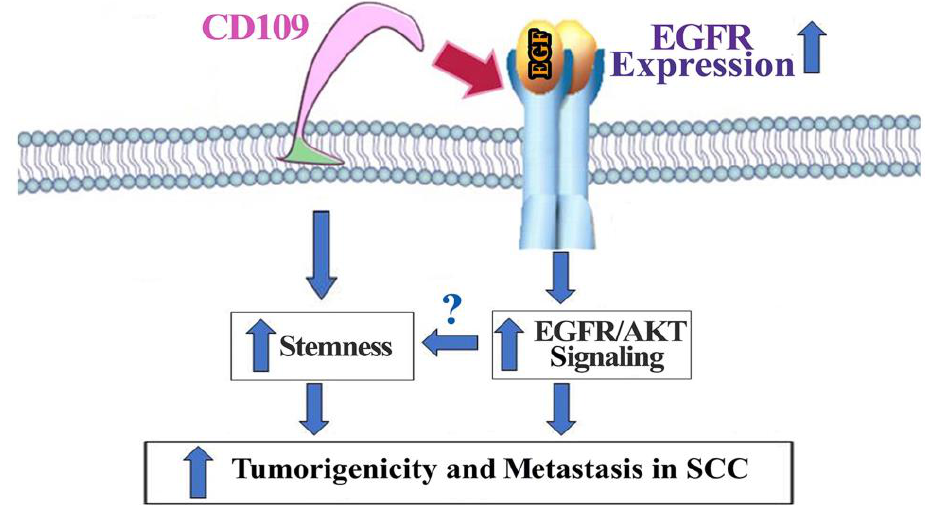
Figure 8. Schematic representation of the proposed mechanisms by which CD109 acts as an essential regulator of EGFR expression and EGFR/AKT signaling and a driver of tumor formation in squamous cell carcinoma. CD109 interacts with EGFR to maintain the levels of EGFR expression, promote EGFR/AKT signaling, and increase cancer cell stemness via EGFR/AKT or other pathways to increase tumorigenicity and metastasis in SCC.